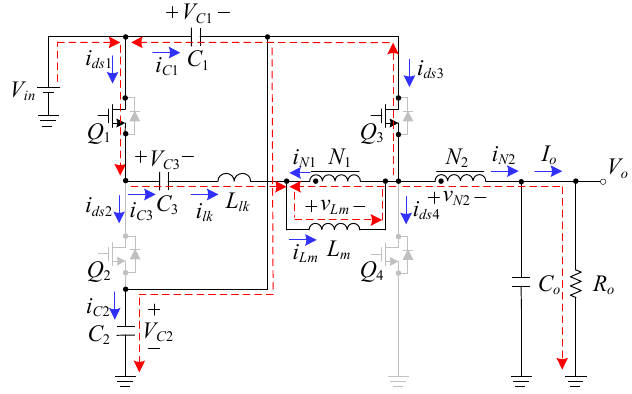
Figure 5. Current flow during state 2.